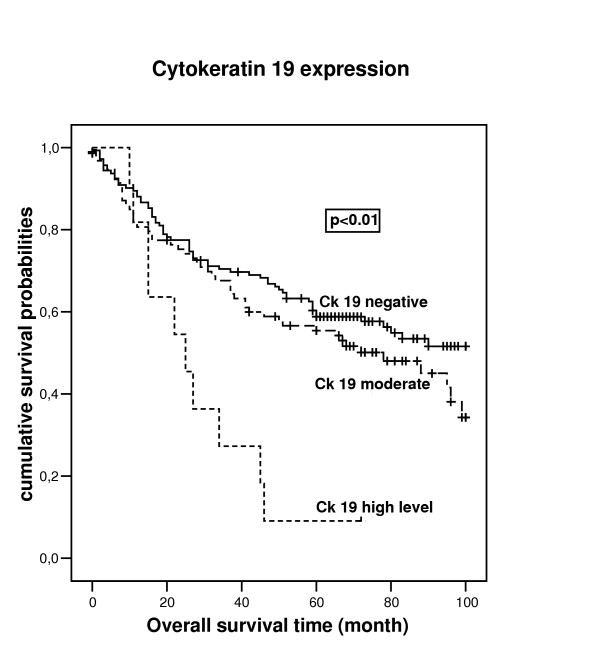
Overall survival of patient with oral squamous cell carcinoma in dependence on Cytokeratin 19 expression calculated by the Kaplan-Meier method.